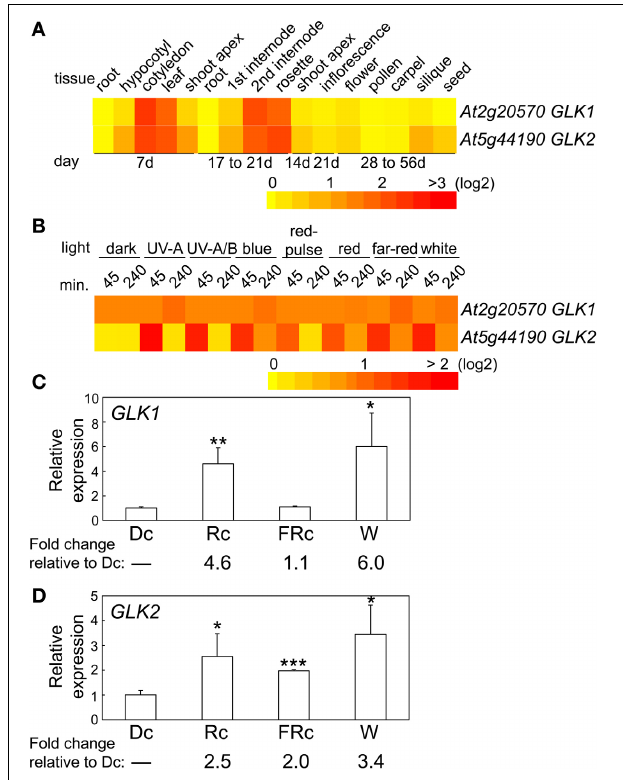
FIGURE 4 | Expression of GLK1 and GLK2 in different tissues and light conditions. (A) Heat map showing the expression of GLK1 or GLK2 in different tissues indicating mean-normalized values of Col-0 WT from AtGenExpress expression library (www.weigelworld.org) and BAR Heatmapper Plus (bar.utoronto.ca). (B) Heat map showing the expression of GLK1 or GLK2 in different light conditions for aerial parts (hypocotyl and cotyledons) of 4-days-old Col-0 WT seedlings grown on MS medium treated with different light for either 45 or 240min. qRT-PCR analysis of (C) GLK1 or (D) GLK2 expression in Col-0 WT under dark (Dc), Rc, FRc, or white (W). Relative GLK1 or GLK2 expression level compared to UBC21 is shown ( ± SD , n = 3). Statistics: Unpaired, two-tailed Student’s t -test comparing different growth conditions ∗ p < 0 . 05, ∗∗ p < 0 . 01, ∗∗∗ p < 0 .